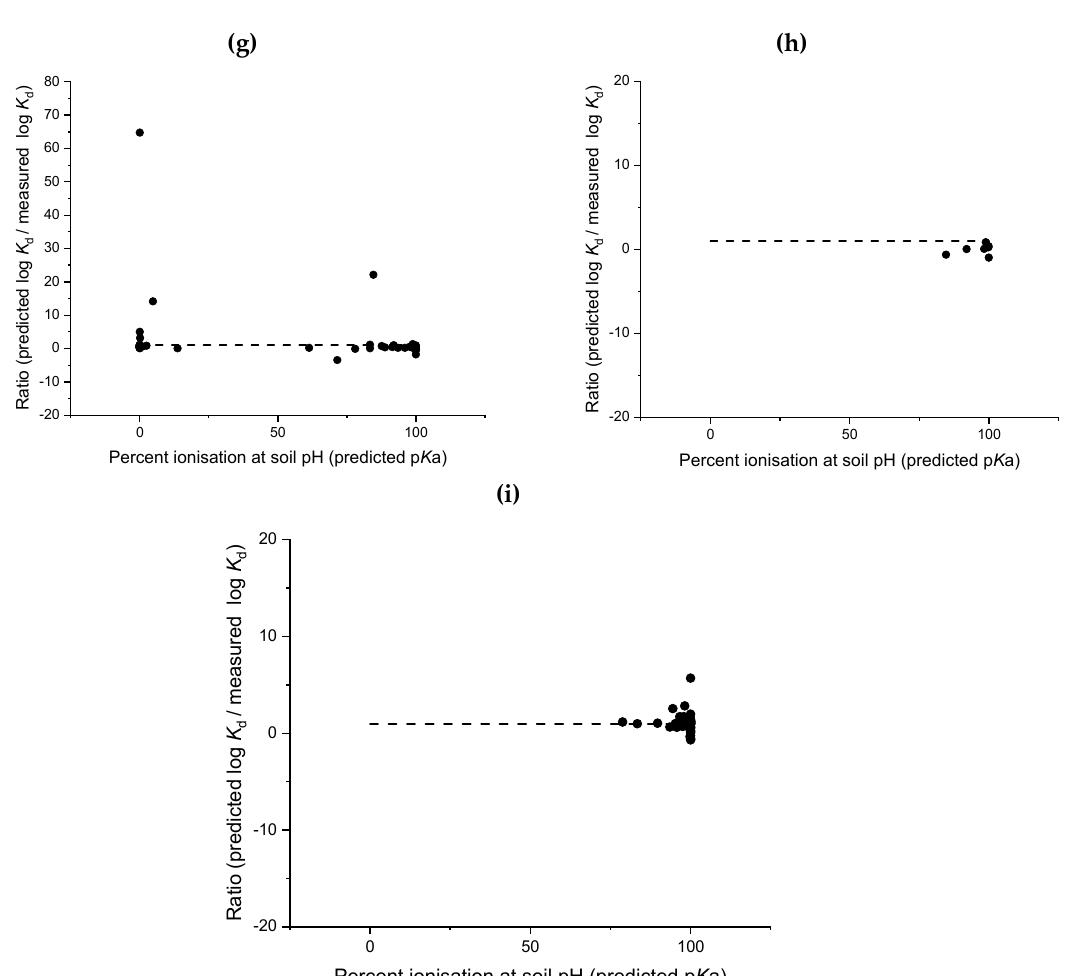
Figure 5. Ratio between predicted and measured soil sorption coefficients and relationship to percent ionisation of test compound, Bintein and Devillers [28] acids ( a ); Bintein and Devillers [28] bases ( b ); Sabljic et al. [37] acids ( c ); Sabljic et al. [37] hydrophobics ( d ); Franco et al. [31] acids ( e ); Franco et al. [31] bases ( f ); Franco et al. [16] ( g ); Kah and Brown [24] ( h ); Droge and Goss [30] ( i ).